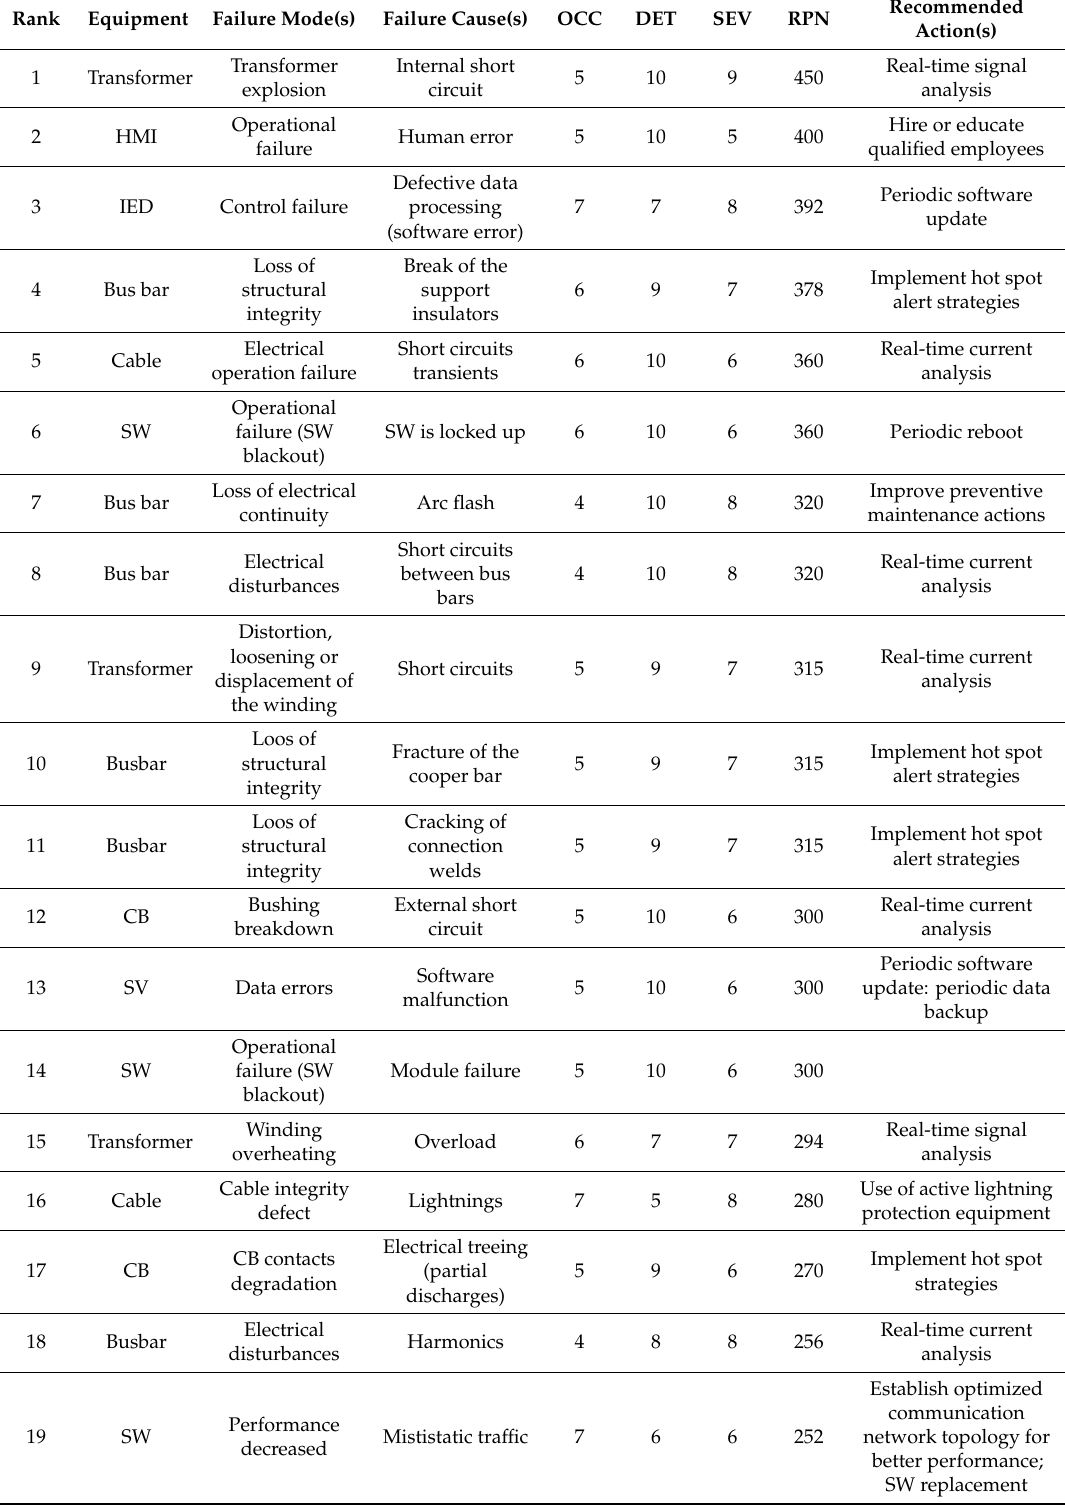
Table 10. Final RPN obtained for highest risk selected failure